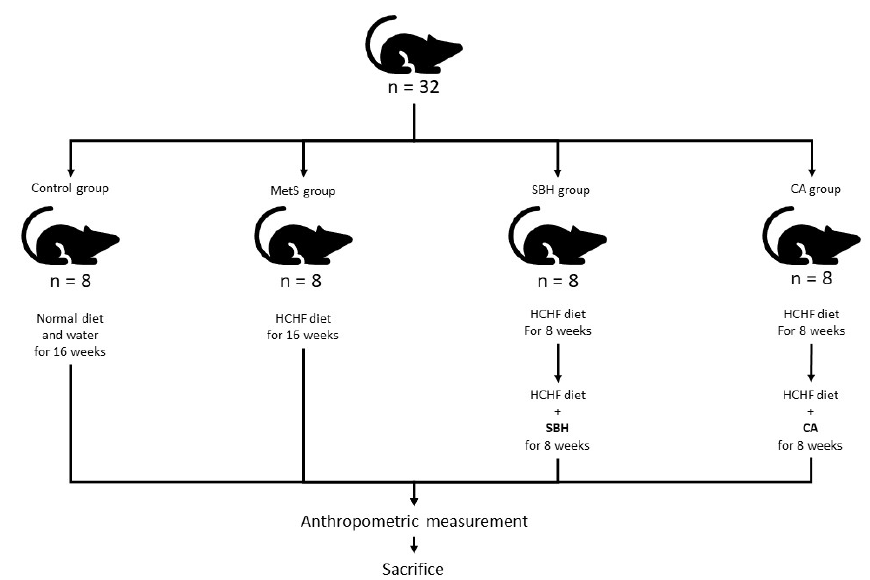
Figure 1. Schematic diagram of groups and treatments: HCHF, high-carbohydrate/high-fructose; SBH, stingless bee honey; CA, caffeic acid.